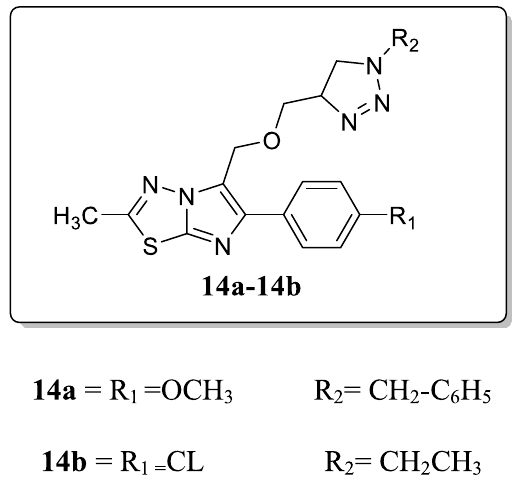
A novel series of triazole – imidazo[2,1-b][1,3,4]thia- diazole hybrids and evaluated their antimycobacterial activity against Mycobacterium tuberculosis H37Rv strain reported by Rampprasad et al .. From the result, two derivatives 14a and 14b demonstrated potent growth inhibition towards the bacterial strain with significant MIC value 3.125 μ g/mL. Substitution of the ethyl benzyl group on 1,2,3-triazole ring enhances the inhibition activity